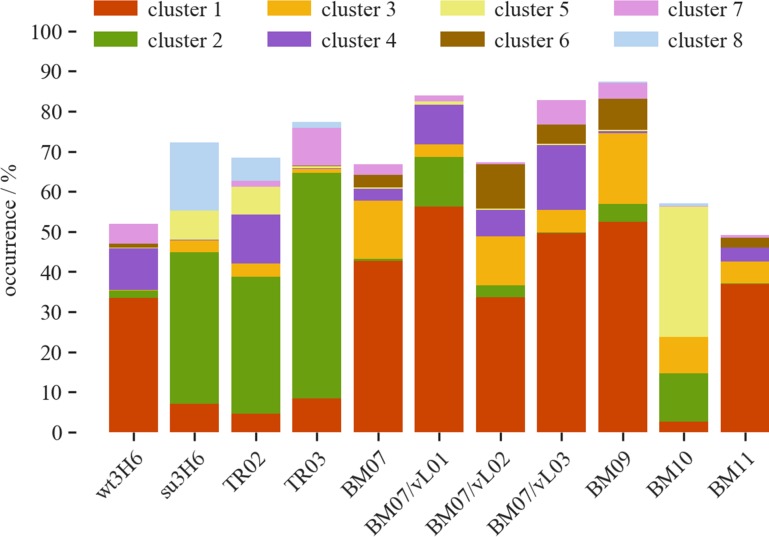
Clusters of CDRh3 loop structure for wt3H6, su3H6, TR02, TR03, BM07, BM09-11 and BM07/vL01-03 including only clusters with overall occurrence >2%.